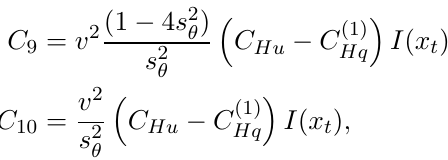
Figure 7 . Diagrams generating contributions to b ! sl + l (cid:0) and/or b ! s(cid:13) from the Q (3) Diagrams in which the operator attaches to the b quark leg imply also the existence (and inclusion in our calculations) of similar diagrams with the operator attached to the s quark